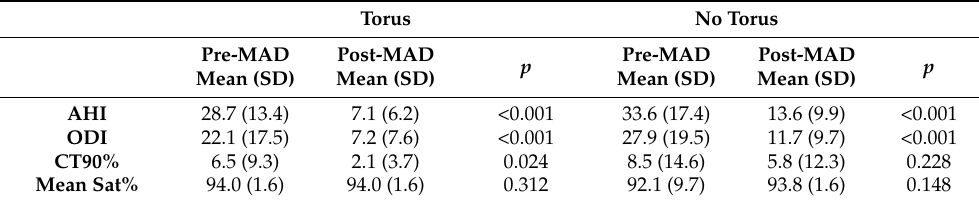
Table 3. Overall changes in respiratory variables according to the groups (Torus or No Torus).